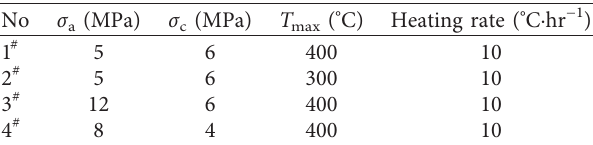
Figure 3: Heating rate of sample 1 # recorded in the experiment. Table 1: Testing conditions of all samples.